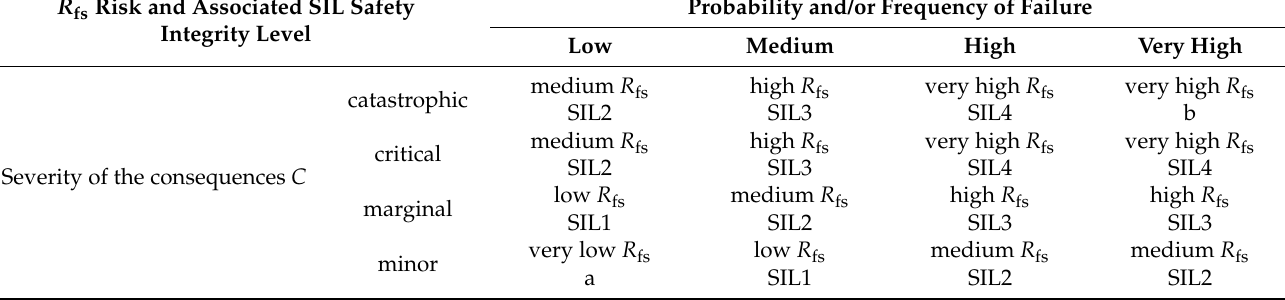
Table 7. Risk Matrix for Functional Safety